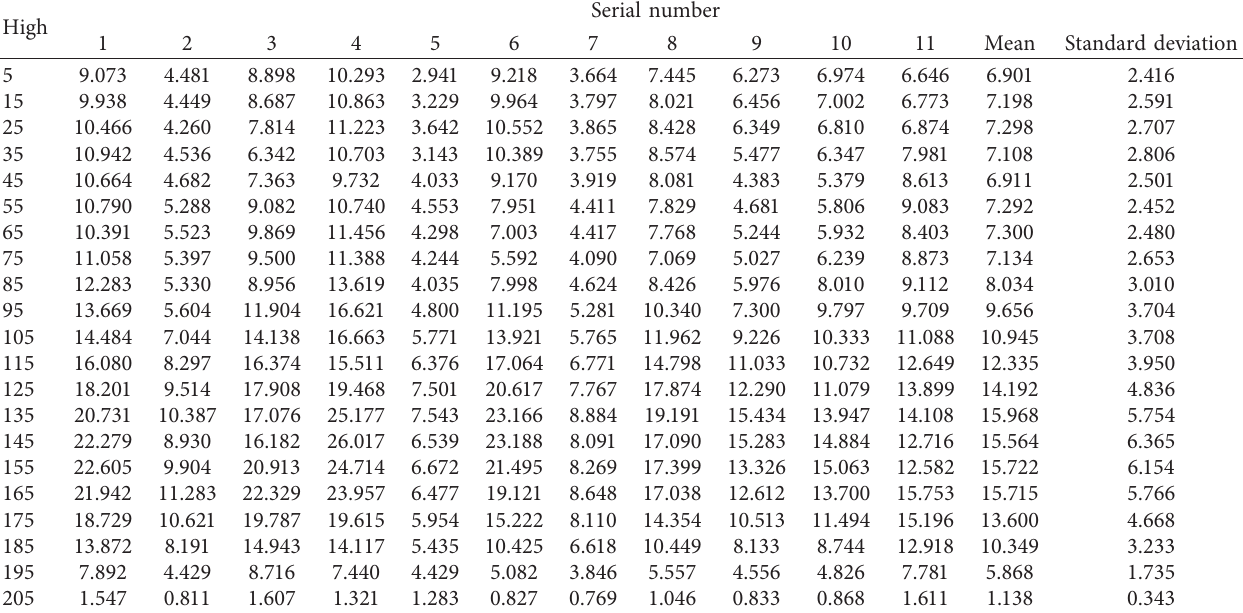
Table 9: Maximum earthquake compressive stresses of the 210m high chimney considering vertical eccentricities.